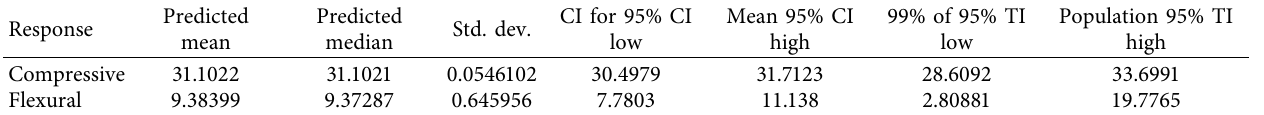
Table 25: Point prediction.